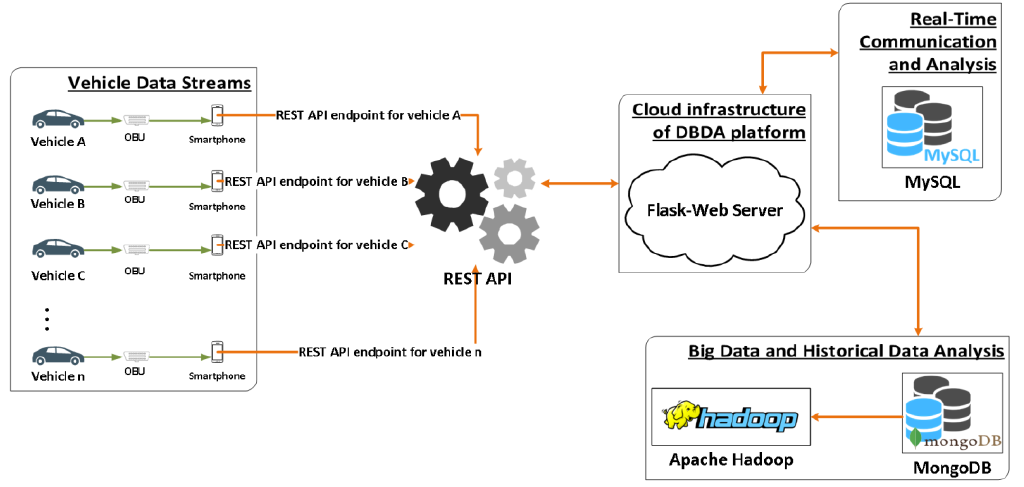
Figure 2. REST API for vehicle sensor data flow.